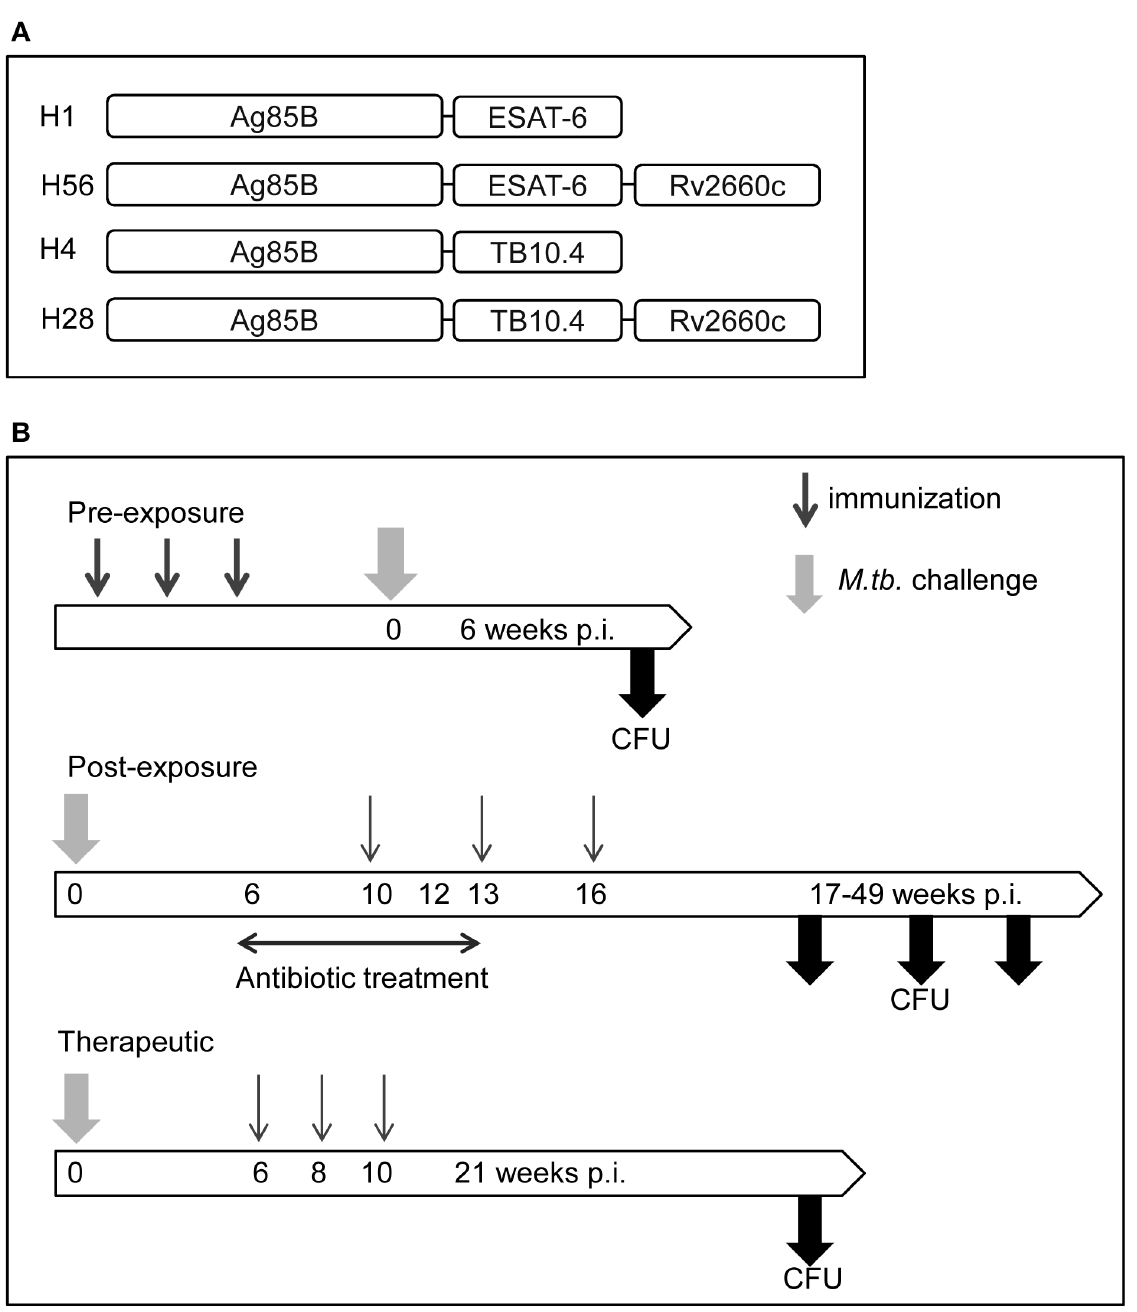
Figure 2. The vaccine constructs and animal challenge models. (A) A schematic overview of the multi-component vaccine constructs which include the ESAT-6-containing vaccines: H1 (Ag85B-ESAT-6) and H56 (Ag85B-ESAT-6-Rv2660c), and the TB10.4-containing vaccines: H4 (Ag85B-TB10.4) and H28 (Ag85B-TB10.4-Rv2660c). (B) Experimental setups for the pre-exposure, post-exposure and therapeutic models. Pre-exposure model : Mice receive three immunizations with a two week interval between each immunization. Six weeks after the last immunization, mice were aerosol challenged with 100 CFU of M.tb . Erdman. Six weeks post-infection (p.i.) mice were sacrificed and CFU levels monitored in the lungs. Post-exposure model : Mice receive an aerosol challenge with 50 CFU of M.tb . Erdman. After six weeks of infection, antibiotics are administered through the drinking water for a six week period. Vaccinations are given at week 10, 13, and 16 after infection. CFU levels in the lungs are monitored between week 17 and 49 p.i. Therapeutic model : Mice receive an aerosol challenge with 50 CFU of M.tb . Erdman. The mice receive three immunizations with two weeks interval (starting at week 6 p.i.), and the CFU levels in the lungs are monitored at week 21 p.i. doi: 10.1371/journal.pone.0080579.g002 PLOS ONE |